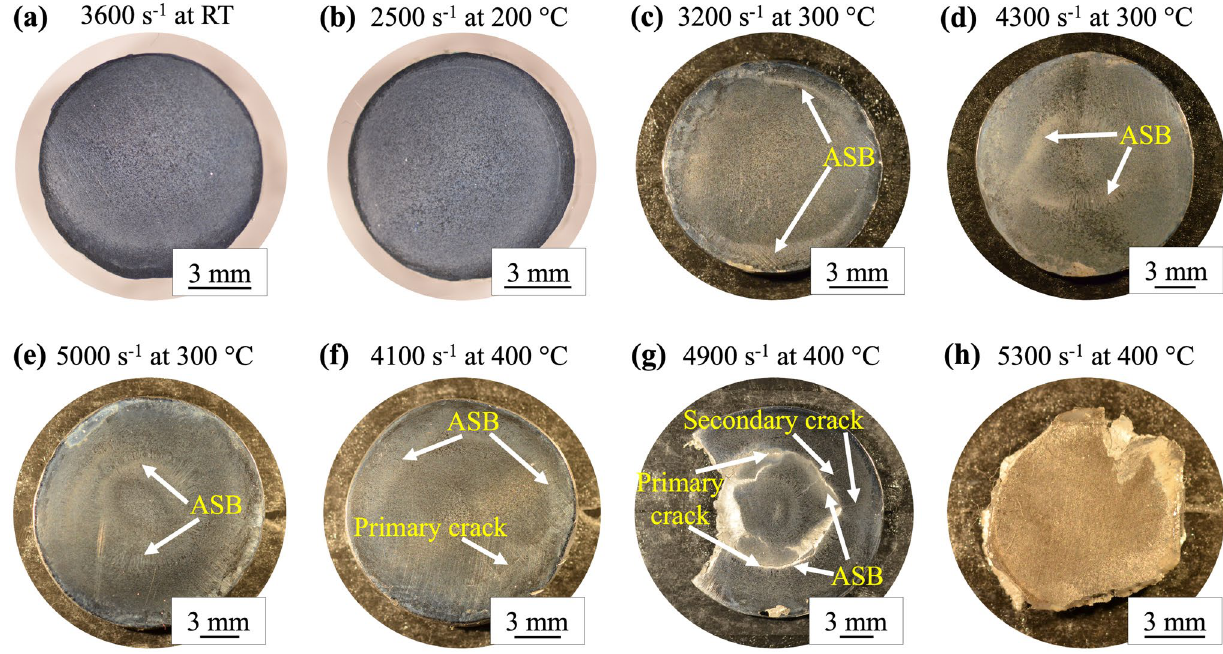
Fig. 7 Macrographs of specimens of AA7075-T651 deformed with ( a ) 3600 s −1 at RT, ( b ) 2500 s −1 at 200 °C, ( c ) 3200 s −1 at 300 °C, ( d ) 4300 s −1 at 300 °C, ( e ) 5000 s −1 at 300 °C, ( f ) 4100 s −1 at 400 °C, ( g ) 4900 s −1 at 400 °C, and ( h ) 5300 s −1 at 400